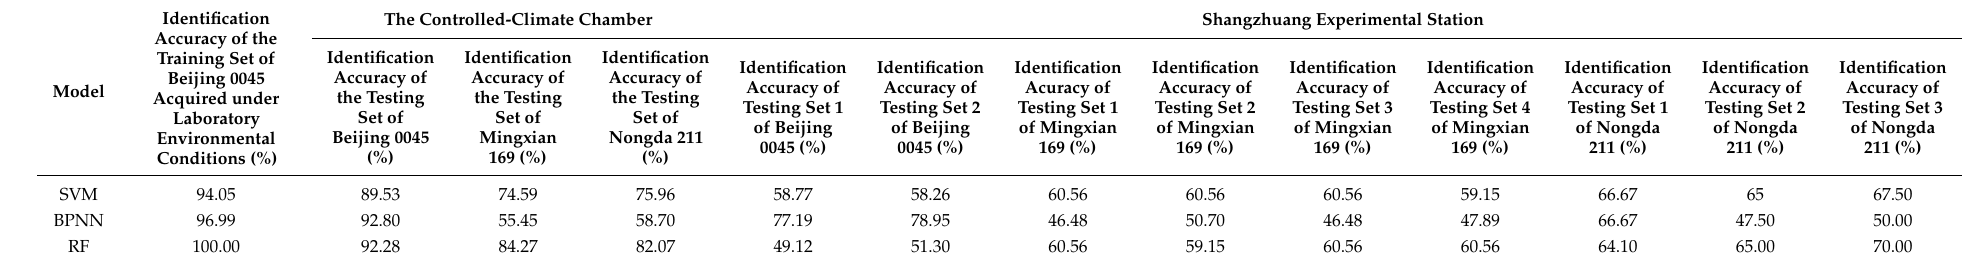
Table 14. Identification results for the individual-variety disease image testing sets acquired under laboratory environmental conditions and in the wheat field in Shangzhuang Experimental Station and the additional testing set consisting of the multi-variety disease images acquired in the wheat field in Gangu Testing Station, using the SVM, BPNN, and RF models built based on the training set of the variety Beijing 0045, itself consisting of disease images acquired under laboratory environmental conditions.